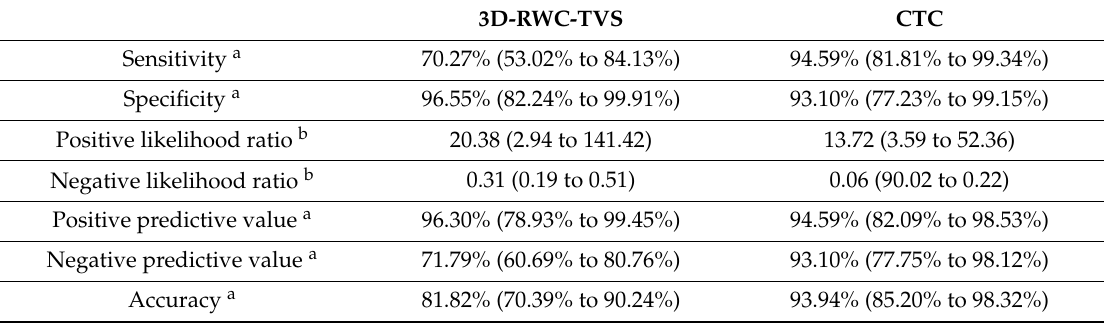
Table 2. Diagnostic performance of 3D-RWC-TVS and CTC in the diagnosis of rectosigmoid endometriosis.